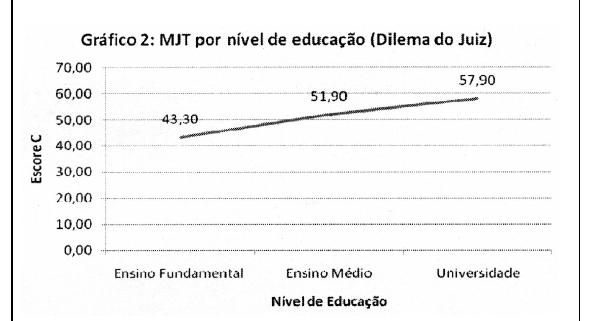
Figura 2 . MJT por nível de educação - Dilema do Juiz (Bataglia, Schillinger-Agati, Lind, & Quevedo, 2003) Os índices superiores nesse trabalho serão comenta- dos mais